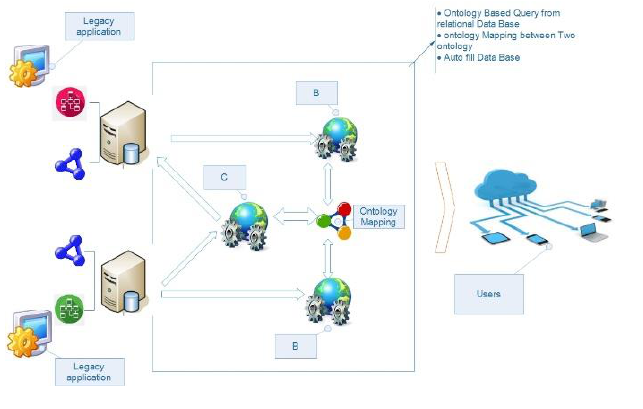
Figure 1. System Architecture